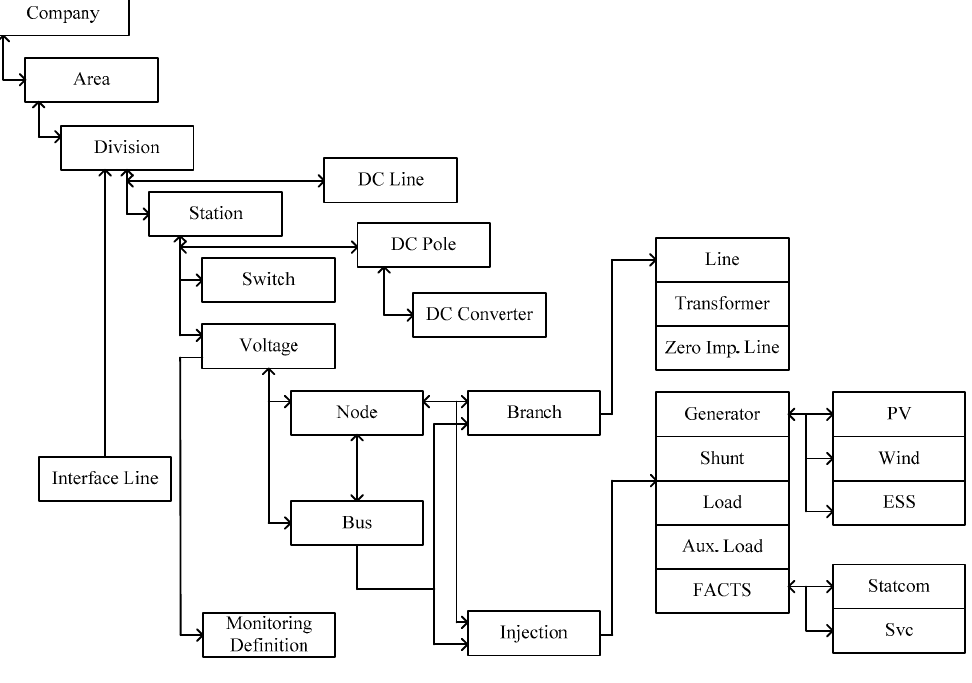
Figure 2. State estimation database.